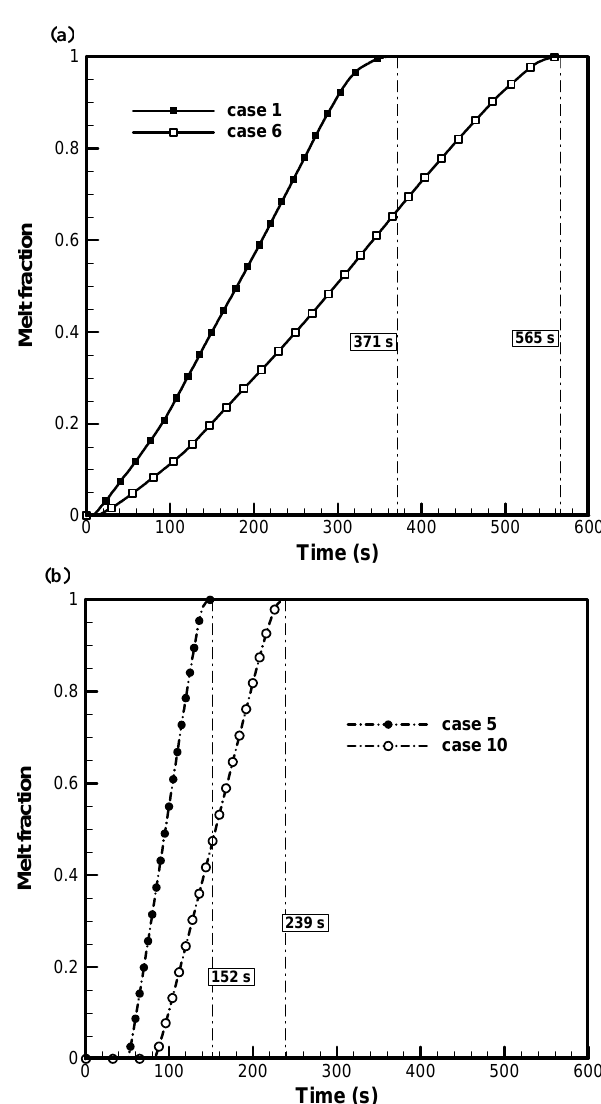
Figure 11. Melt fraction evolution with time for different fin heights: (a) various cases for 25 fins and w F = 2mm and (b) var- ious cases for 100 fins and w F = 6mm.